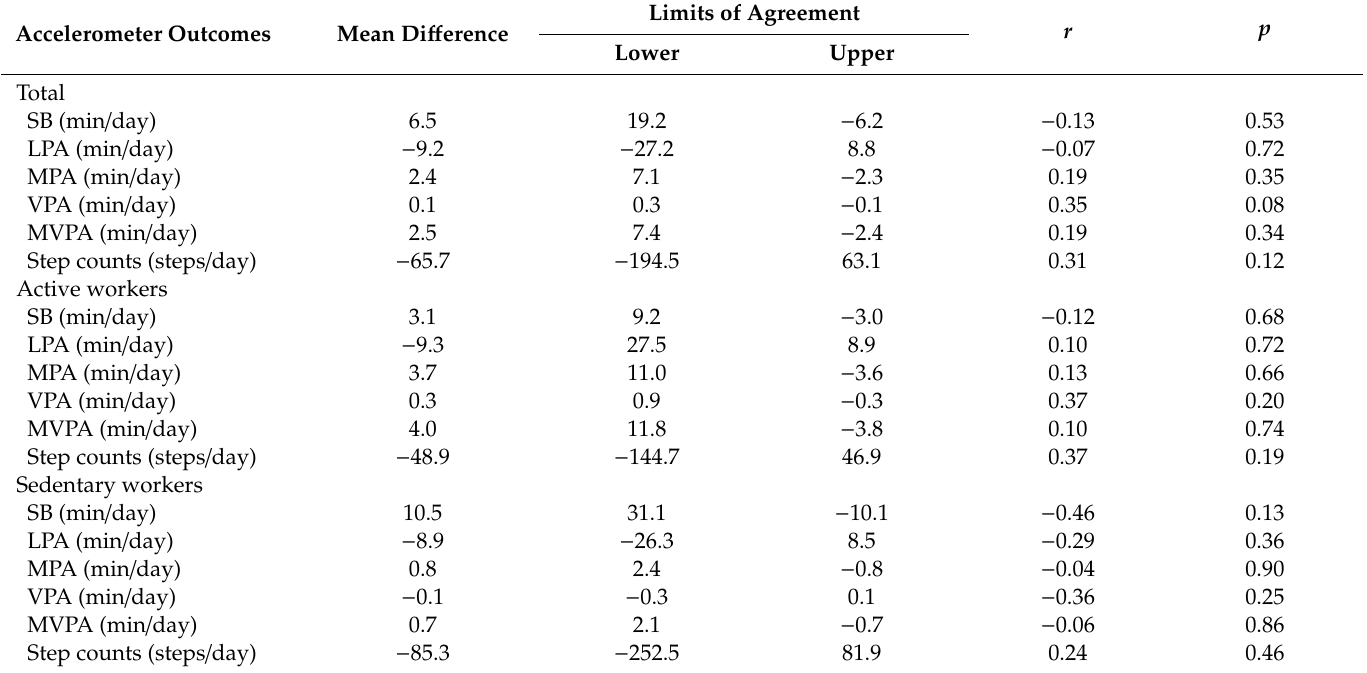
Table 3. Mean of di ff erence and limits of agreement between 750C and 350IT